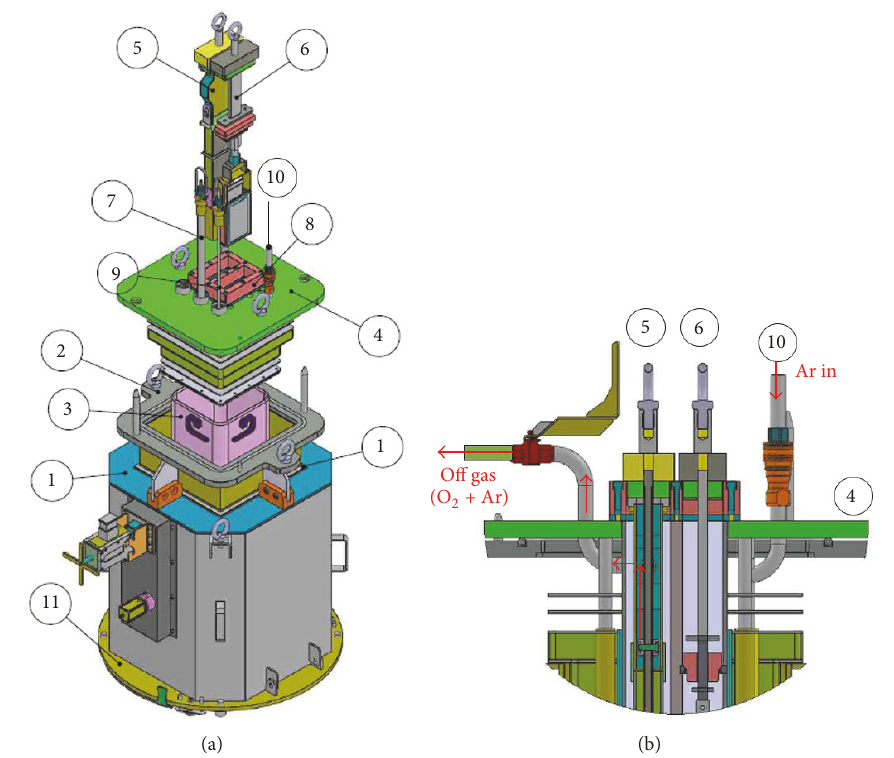
Figure 2: Schematic of the OR apparatus used for this study: (a) outer view ( A : furnace, B : outer STS crucible, C : inner STS crucible, D : top flange, E : cathode, F : anode, G : reference electrode, H : electrical insulator, 0 : thermocouple, 1 : Ar inlet, and 2 : bottom) and (b) flow of incoming Ar and evolved gas (Ar + O 2 ) through the top flange.